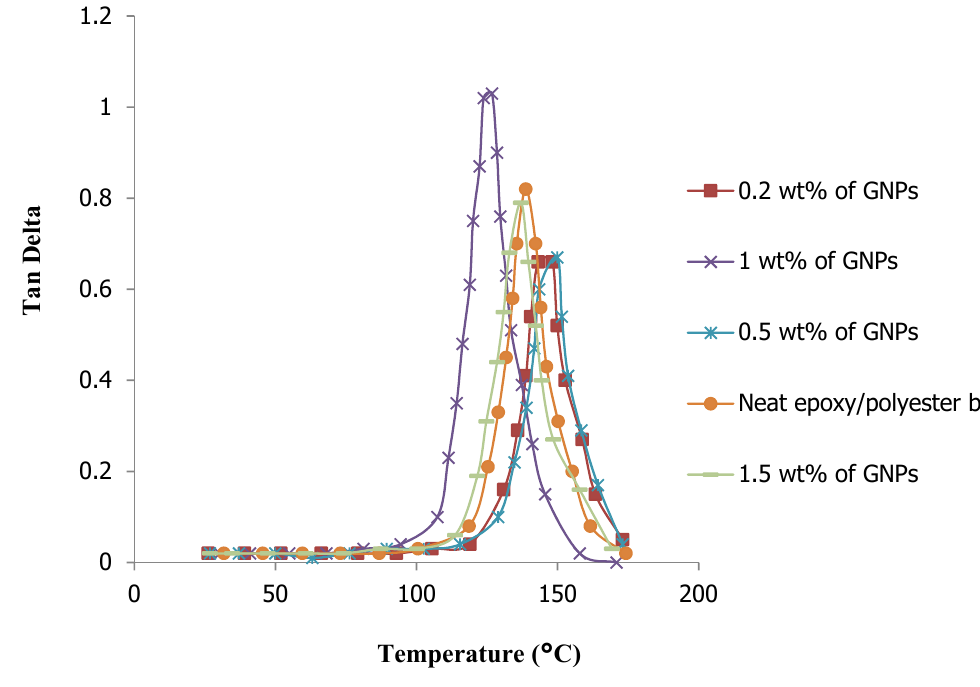
Figure 6. Relationship between the loss factor (tan δ ) and temperature of GNP-reinforced hybrid composite specimens.